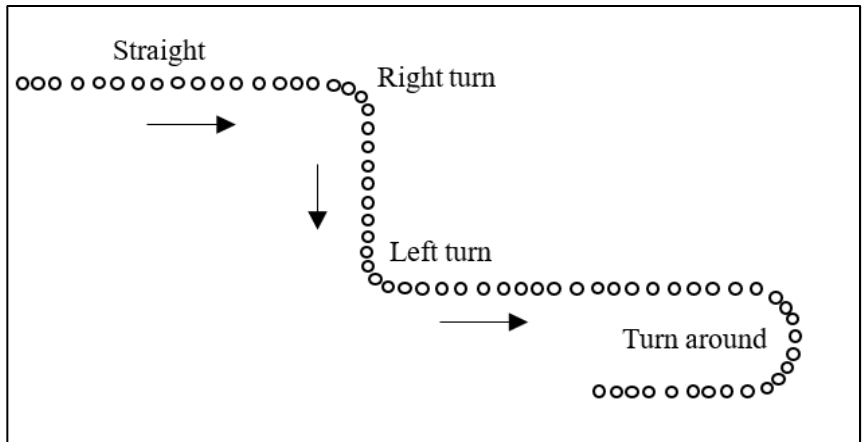
Figure 1. Diagram of cycling trajectory-based navigation.